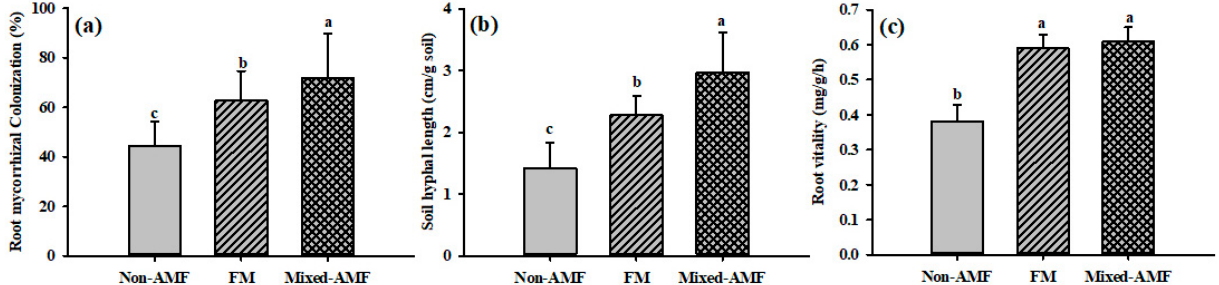
Figure 2. Effects of AMF inoculation on the degree of root mycorrhizal colonization ( a ), mycorrhizal hyphal length in soil ( b ), and root vitality ( c ) of Ponkan mandarin, grafted on trifoliate orange under field condition. Means ± SD ( n = 5) followed by different letters at the bar indicate significant differences ( p < 0.05) among treatments. The data were collected in 2019, the second year after AMF inoculation.